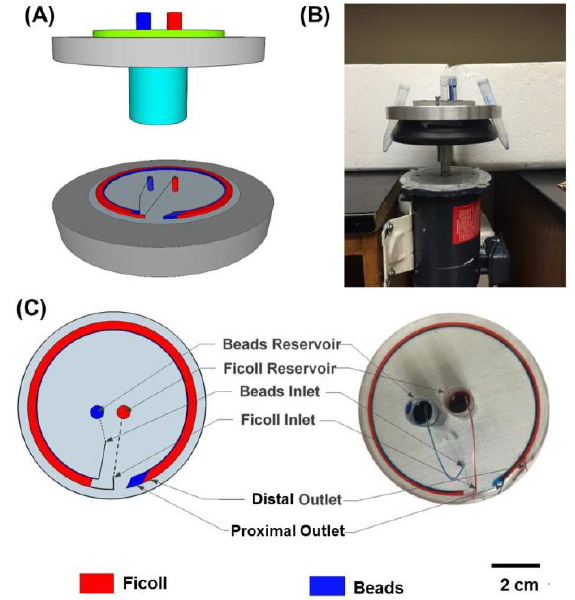
Figure 1. Setup for microfluidic density-gradient centrifugation. ( A ) Simplified schematic of the device; ( B ) Picture of the centrifugation system consisting of the custom-designed rotary platform mounted onto the motor to hold the microfluidic device; ( C ) Schematic and actual image of layering of colored 1X PBS streams within the device.